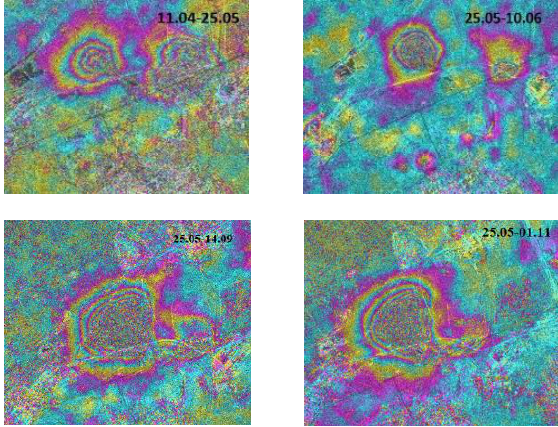
Figure 6. Samples of differential interferogram of the area of T. Kuzembaev mine based on different image pairs As a result of space pictures processing subsidence isolines and earth surface subsidence graph for the specific point with the maximum subsidence were made. From the schedule it is nota- ble that the maximum subsidence during supervision period made more than 145mm (Figure 7).